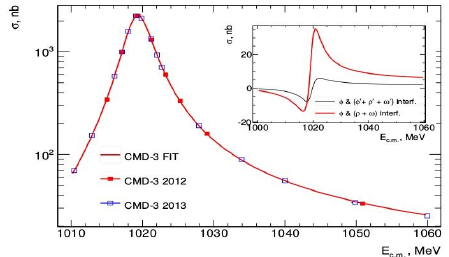
Figure 7. (a) e + e − → K 0 sured in the CMD-3 experiment. (b) Relative dif- ference between the data and fit.